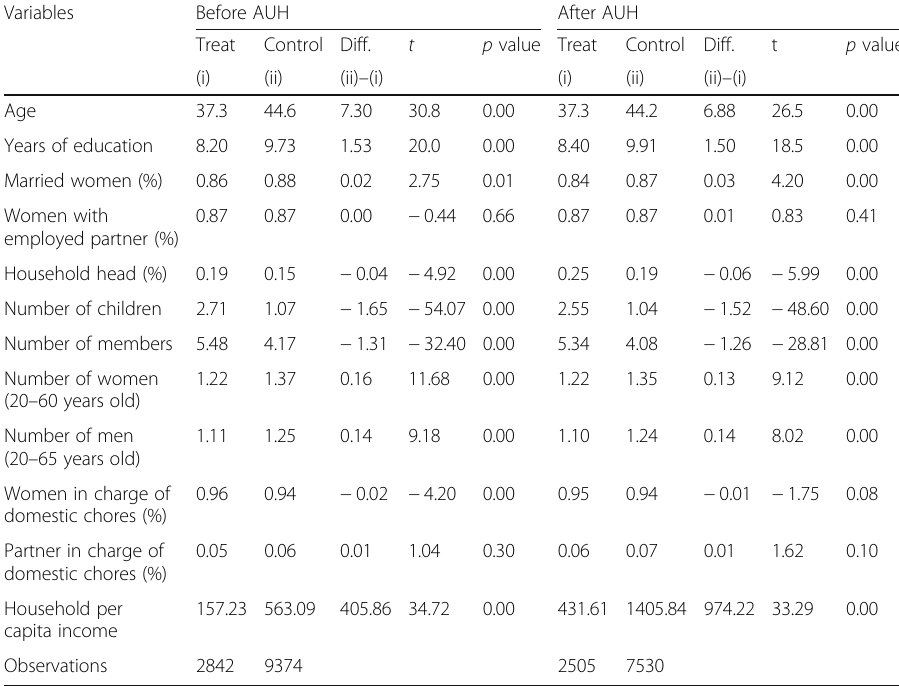
Table 1 Descriptive statistics of estimation sample. Women aged 20 – 60 — head of household or spouse Variables Before AUH After AUH Treat Control Diff. p value